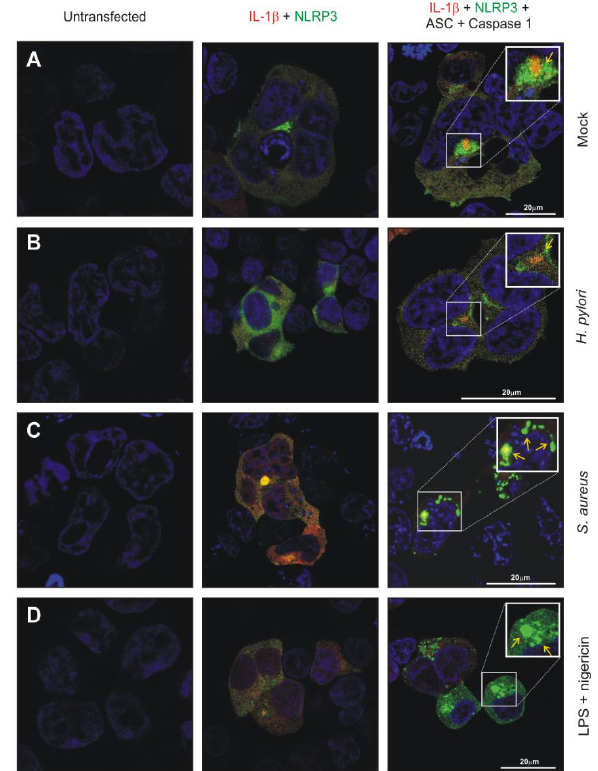
Figure 6. Confocal laser scanning microscopy was used to analyze the reconstructed